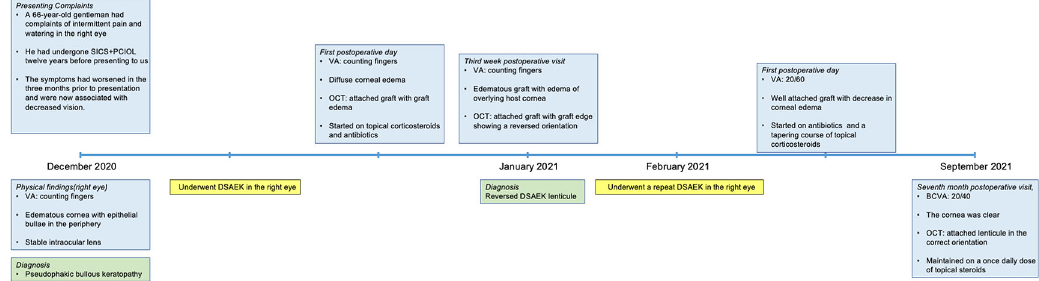
Figure 3. Timeline of the patient from presentation to the last follow up with details of the clinical features, interventions, and outcomes. SICS: small incision cataract surgery, PCIOL: posterior chamber interocular lens, DSAEK: Descemet stripping automated endothelial keratoplasty, OCT: optical coherence tomography, VA: visual